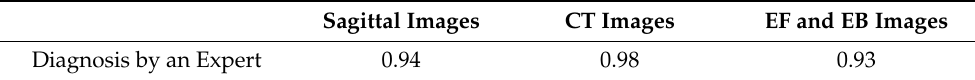
Table 4. The results from the expert (%).